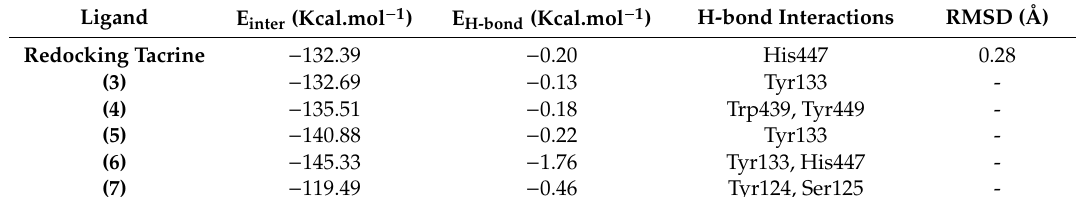
Table 3. Docking results inside AChE from Electrophorus electricus ( Ee AChE).